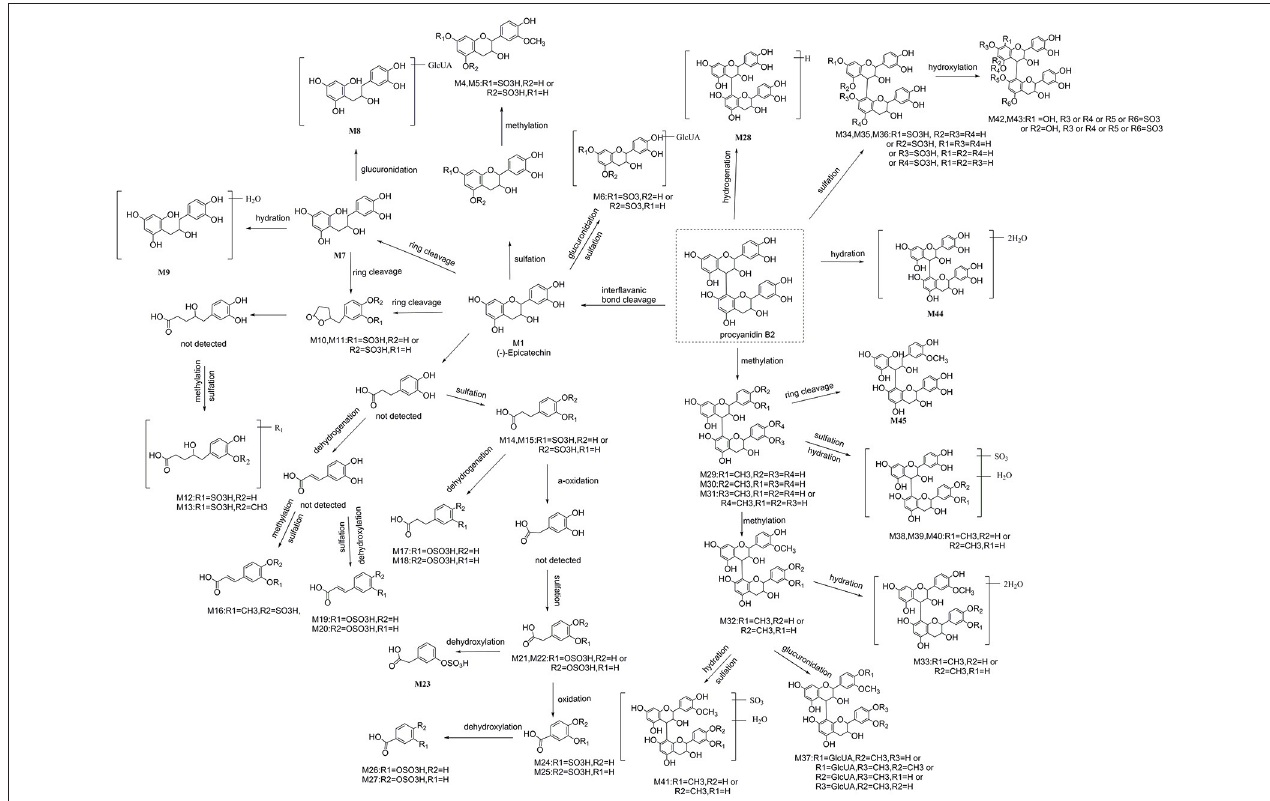
FIGURE 5 | The proposed metabolic pathway of 45 identified metabolites of procyanidin B2 in mice.